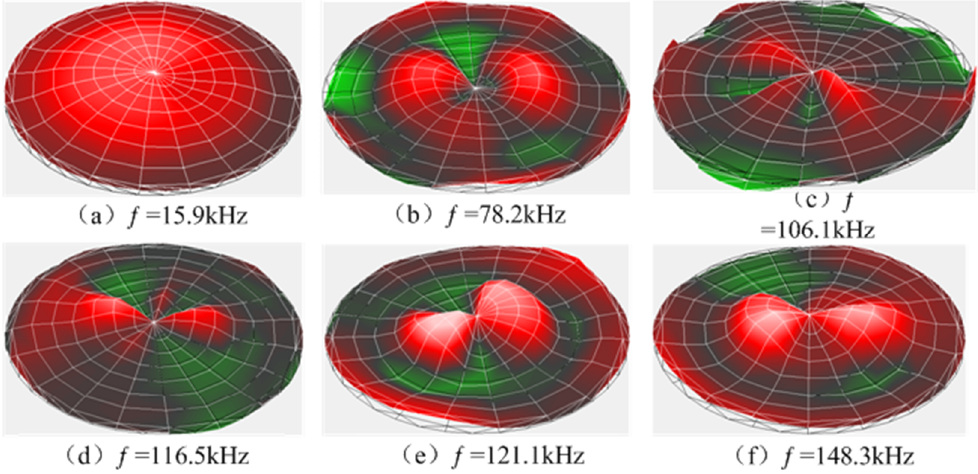
Figure 6. Vibration modes of resonance points [29].